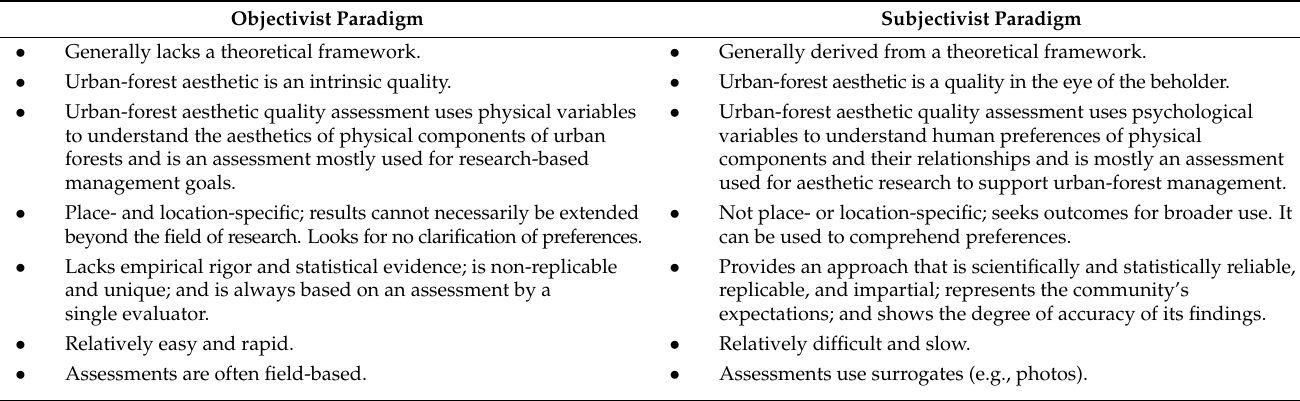
Table 2. Summary of the philosophy paradigms used to assess urban-forest aesthetics.